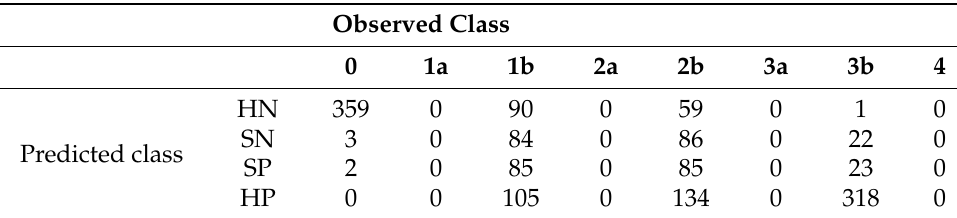
Table 15. Confusion matrix for the validation set and the RF model. Two-class classification.